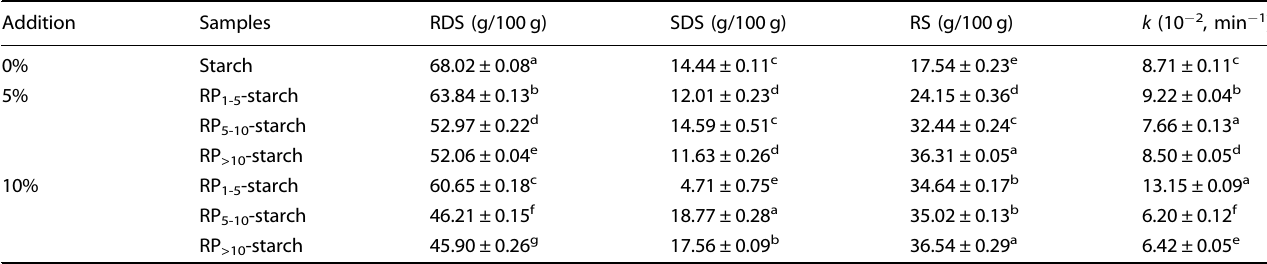
Each value is the mean of three replicates. For the same column, data with same letters do not differ signi fi cantly from each other whereas data with different superscripts differ signi fi cantly at the probability level p <0.05.